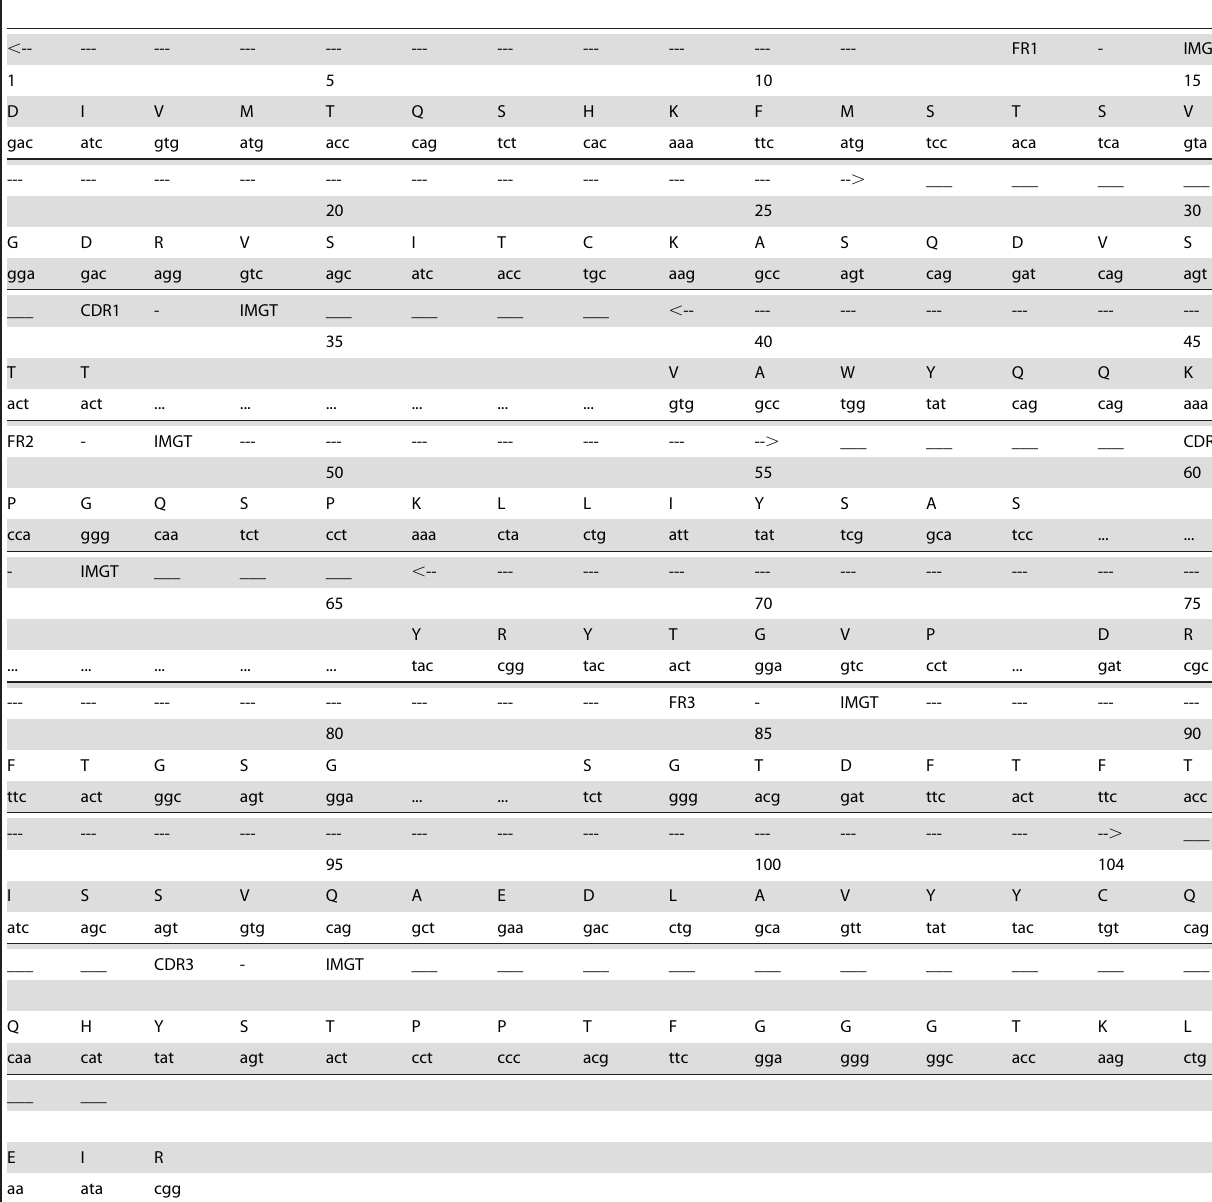
Table 4. Framework (FR) and Complementary Determining Region (CDR) delimitations of the light chain of MAb DB81: DB81